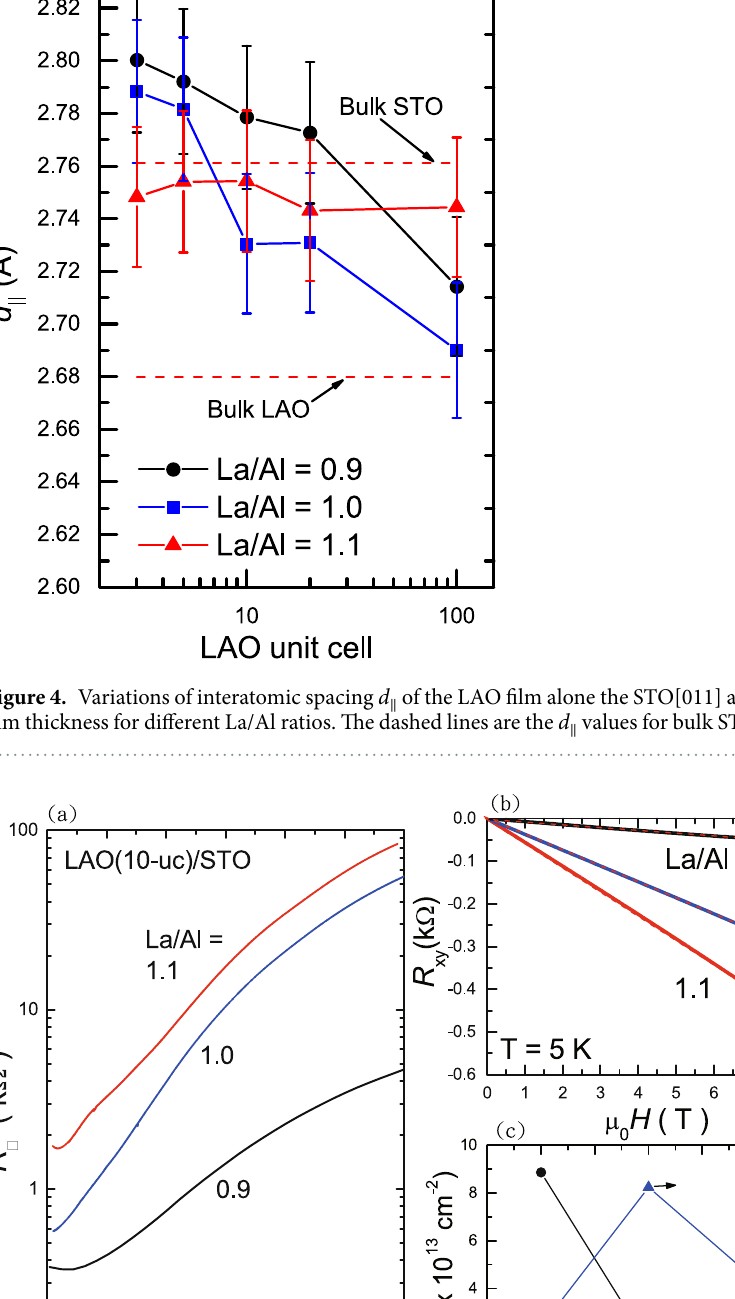
Figure 5. ( a ) Sheet resistance  R versus temperature of 10-uc thin LAO films with different La/Al ratios. ( b ) The Hall resistance as a function of field at T = 5 K. ( c ) The corresponding sheet density n 2 D and Hall mobility μ H versus the nominal La/Al